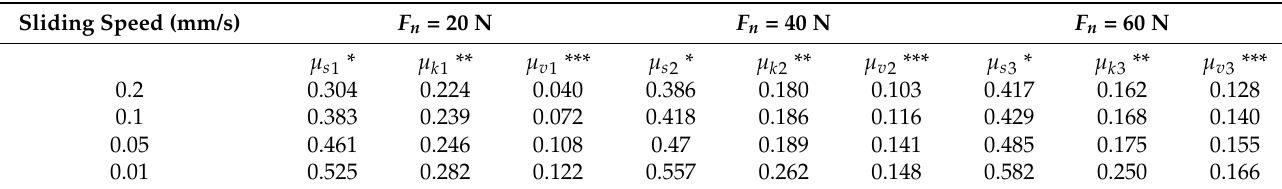
Figure 3. COF and AE amplitude with a driving speed of 0.01 mm/s for the normal force of 20 N ( a ), 40 N ( b ), and 60 N ( c ). Comparison of COF results over time at 60 N force and all driving speeds ( d ). Table 1. Values of the friction coefficients.